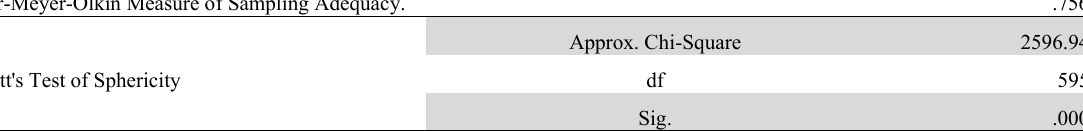
KMO and Bartlett's Test Kaiser-Meyer-Olkin Measure of Sampling Adequacy.